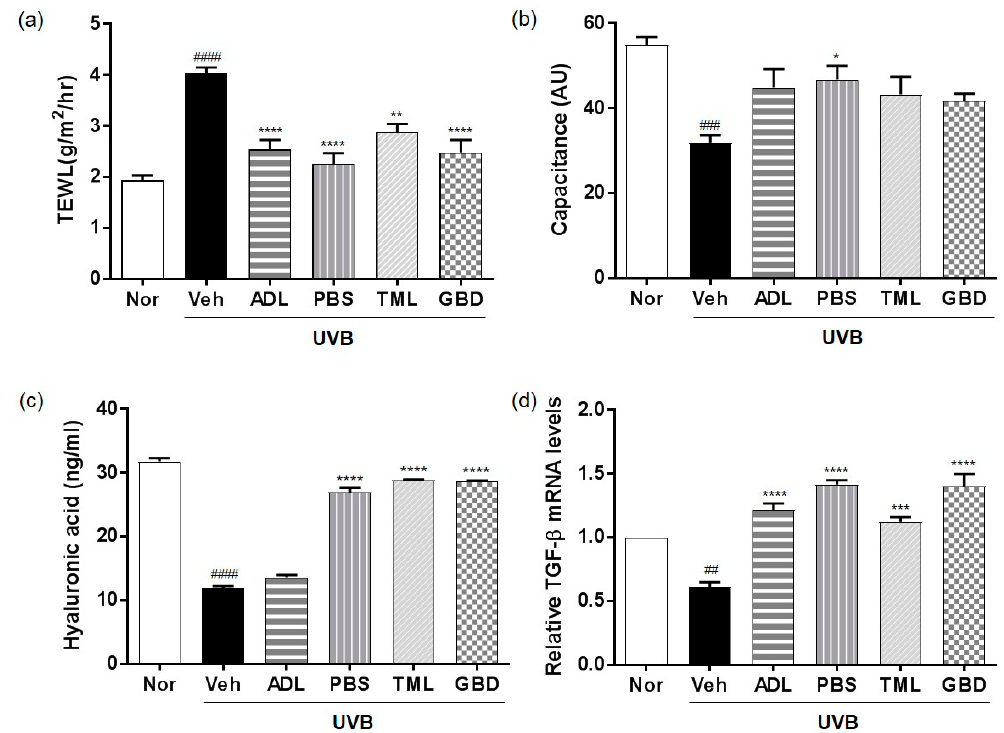
Figure 1. E ff ects of insect extracts on ultraviolet B (UVB)-induced skin hydration. ( a ) Transepidermal water loss (TEWL) and ( b ) capacitance in UVB-irradiated hairless mice after the administration of insect extracts for over 10 weeks. ( c ) Hyaluronic acid (HA), and ( d ) transforming growth factor-beta (TGF- β ) mRNA. #### p < 0.0001, ### p < 0.001 and ## p < 0.01 vs. the normal group, and **** p < 0.0001, *** p < 0.001, ** p < 0.01 and * p < 0.05 vs. the vehicle group. These measurements were performed in triplicate. Nor, Normal; Veh, Vehicle; ADL, Allomyrina dichotoma larva; PBS, Protaetia brevitarsis seulensis ; TML, Tenebrio molitor Linnaeus; GBD, Gryllus bimaculatus De Geer.